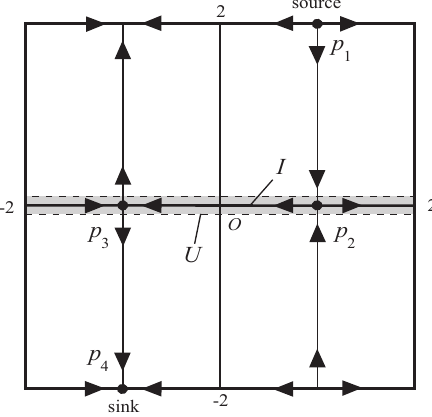
Figure 1. The structure of the stable and unstable